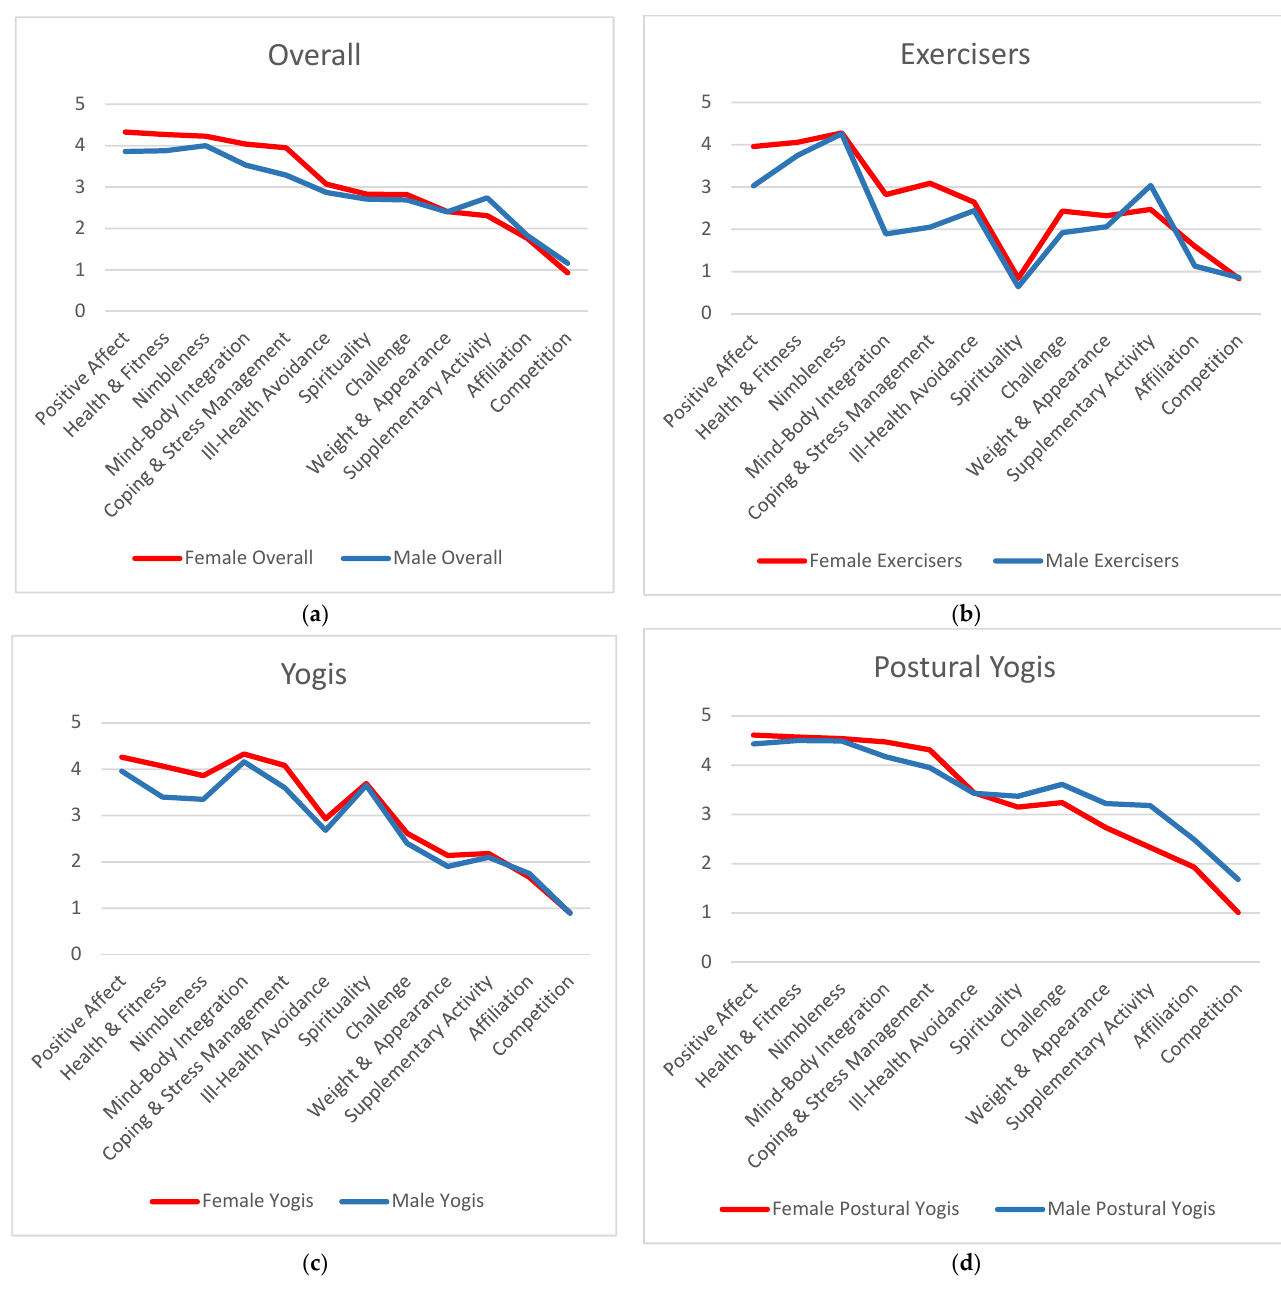
Figure 1. Mean scores on participation motives per gender, for ( a ) all participants, ( b ) Exercisers subgroup, ( c ) Yogis subgroup, and ( d ) Postural Yogis subgroup.